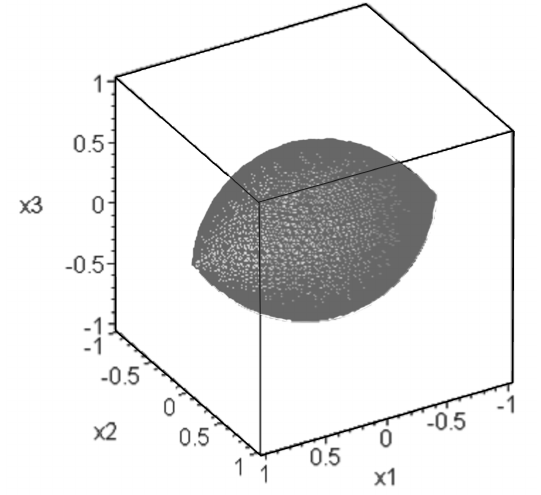
Fig. 4. 3D-image of the limit equilibrium (cid:12)gure in the vicinity of the Sun. The (cid:12)gure has two special points { these are the end points along the O ′ x 1 axis directed radially from the Galactic